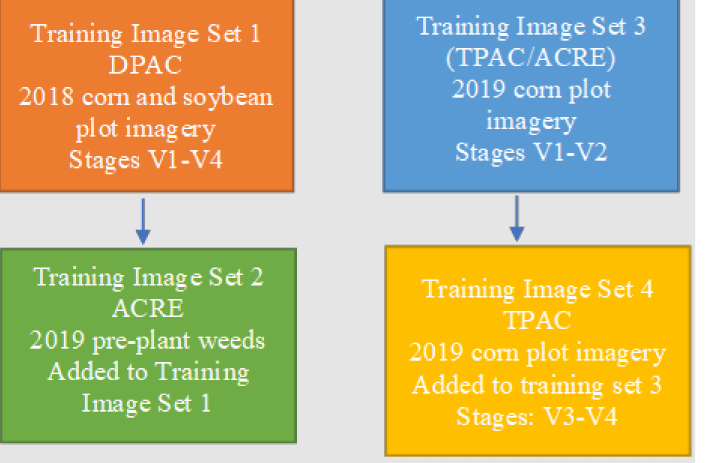
Figure 5. Training image set creation flowchart. All training image sets are trained with YOLOv3.